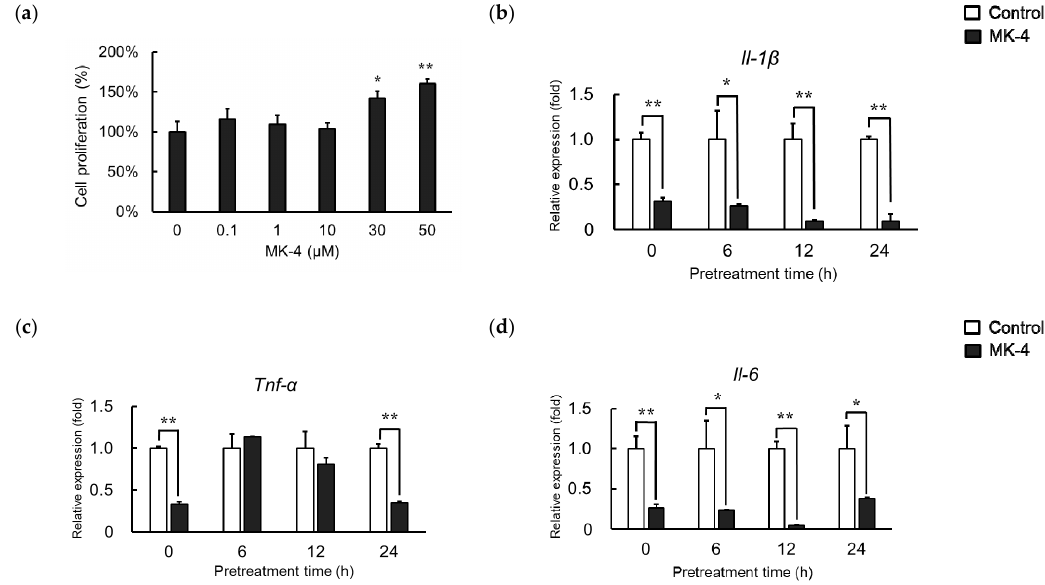
Figure 1. Menaquinone-4 (MK-4) suppresses inflammatory cytokine expression in MG6 cells with di ff erent pretreatment times. ( a ) Various doses of MK-4 (0-50 µ M) were administered to MG6 cells for 24 h. Cell viability was measured by WST-1 assays. ( b , c ) MG6 cells were pretreated with MK-4 (10 µ M) for the indicated times and then exposed with LPS (1 ng / mL) for 3 h. The mRNA levels of proinflammatory cytokines were measured by quantitative reverse transcriptase-PCR, normalized to levels of Eef1a1 (the internal standard), and expressed as the fold-change relative to control cell values (Cont, cells not treated with MK-4); Il-1 β ( b ), Tnf- α ( c ), and Il-6 ( d ). Data are presented as the mean ± S.E.M, n = 3. Values were significantly di ff erent from those of the control at * p < 0.05 and ** p < 0.01.